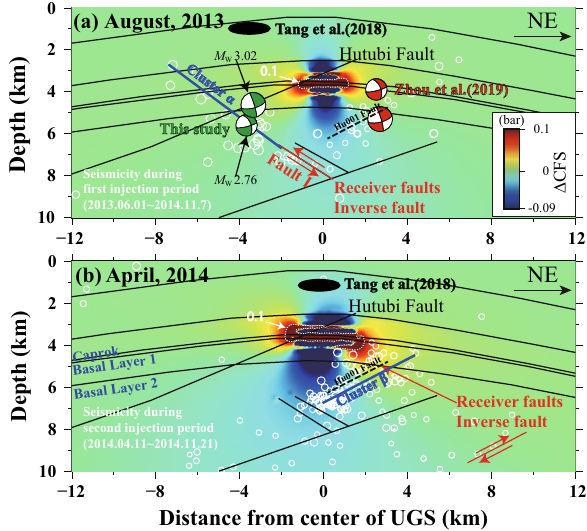
Figure 6. Accumulative Coulomb stress perturbations caused by the operation of the Hutubi UGS were estimated with a hydrogeomechanical model 18 for clusters α ( a ) and β ( b ). The putative receiver faults are set as northeast-dipping with 30° inverse fault and southwest-dipping with 20° inverse fault, and the friction coefficient was fixed at 0.4. White dashed lines mark the boundaries of 0.1 bar increments. The black ellipse shows the location of two clusters reported by Tang et al . 16 . The beach balls represent focal mechanisms of two earthquakes with M L ≥ 3.0 in August 2013, plotted in the locations described by Zhou et al . 22 (red) and by this study (green). The white circles indicate the events during the first ( a ) and second ( b ) injection periods. The two planes outlined by the two clusters are shown as blue lines for the different operating phases. The black dashed lines mark the Hu001 fault, although it is not considered in the hydrogeomechanical model 18